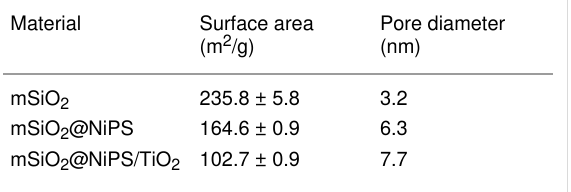
nonporous material (Supporting Information File 1, Figure S2b).